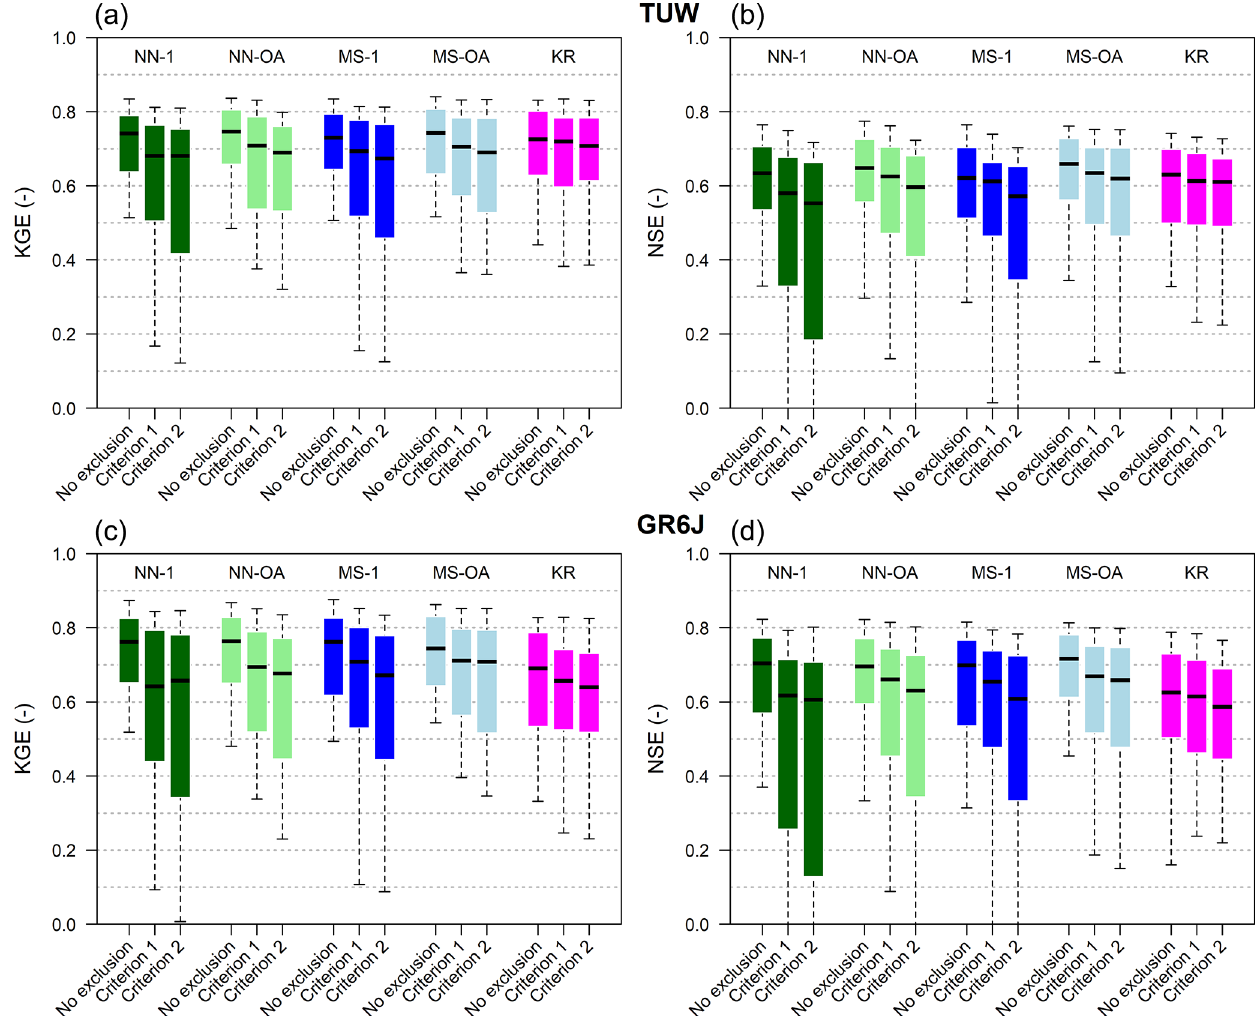
Figure 9. Effect of the exclusion of nested catchments for the subset of 137 watersheds classified as nested: Kling–Gupta (a, c) and Nash– Sutcliffe (b, d) efficiencies when regionalising the TUW (a, b) and GR6J (c, d) models. “No exclusion”: all the donors are available. “Criterion 1” or “Criterion 2”: nested catchments are excluded from the donor set. Box colours refer to the different methods: green is nearest neighbour (1 donor is dark green and three is light green), blue is most similar (1 donor is dark blue and three is light blue) and magenta is ordinary kriging. Boxes extend to 25% and 75% quantiles, while whiskers refer to 10% and 90%